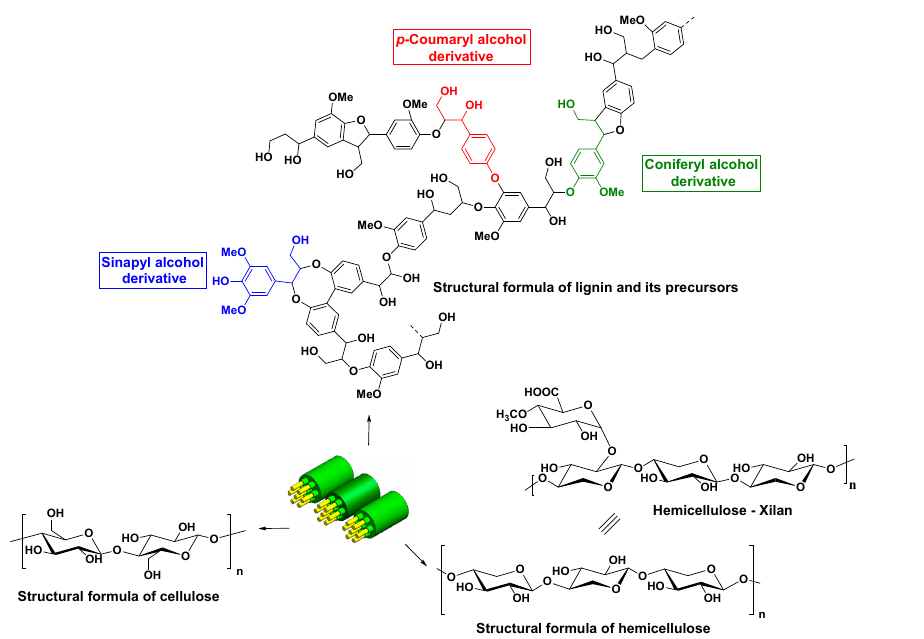
Figure 3. Structuring of lignocellulose biomass and structural formula of the components (Adapted from [20] ).